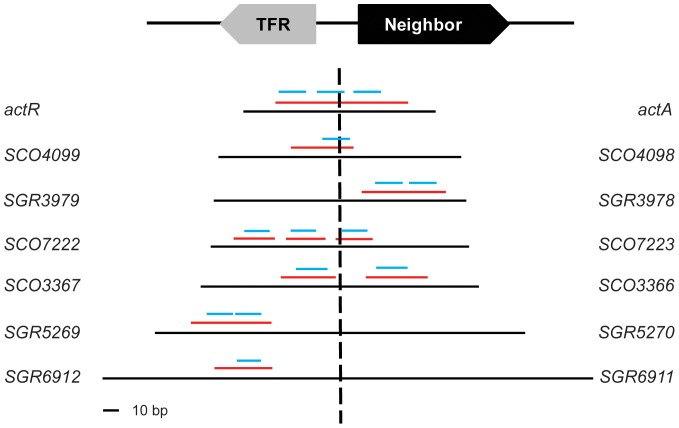
Seven TFRs bind different regions in the intergenic DNAs relative to their divergent neighbors.Solid black horizontal lines represent the intergenic DNAs, while red horizontal lines indicate the regions protected by the TFRs, on one or both strands of the DNAs. Putative operators of the TFRs were identified through sequence analysis of the protected regions, and their positions are indicated by blue horizontal lines. These lines are oriented such that all of the TFR-encoding genes are located on the left side while their divergent neighboring genes are located on the right side. Dashed vertical line represents the center of the intergenic DNAs.